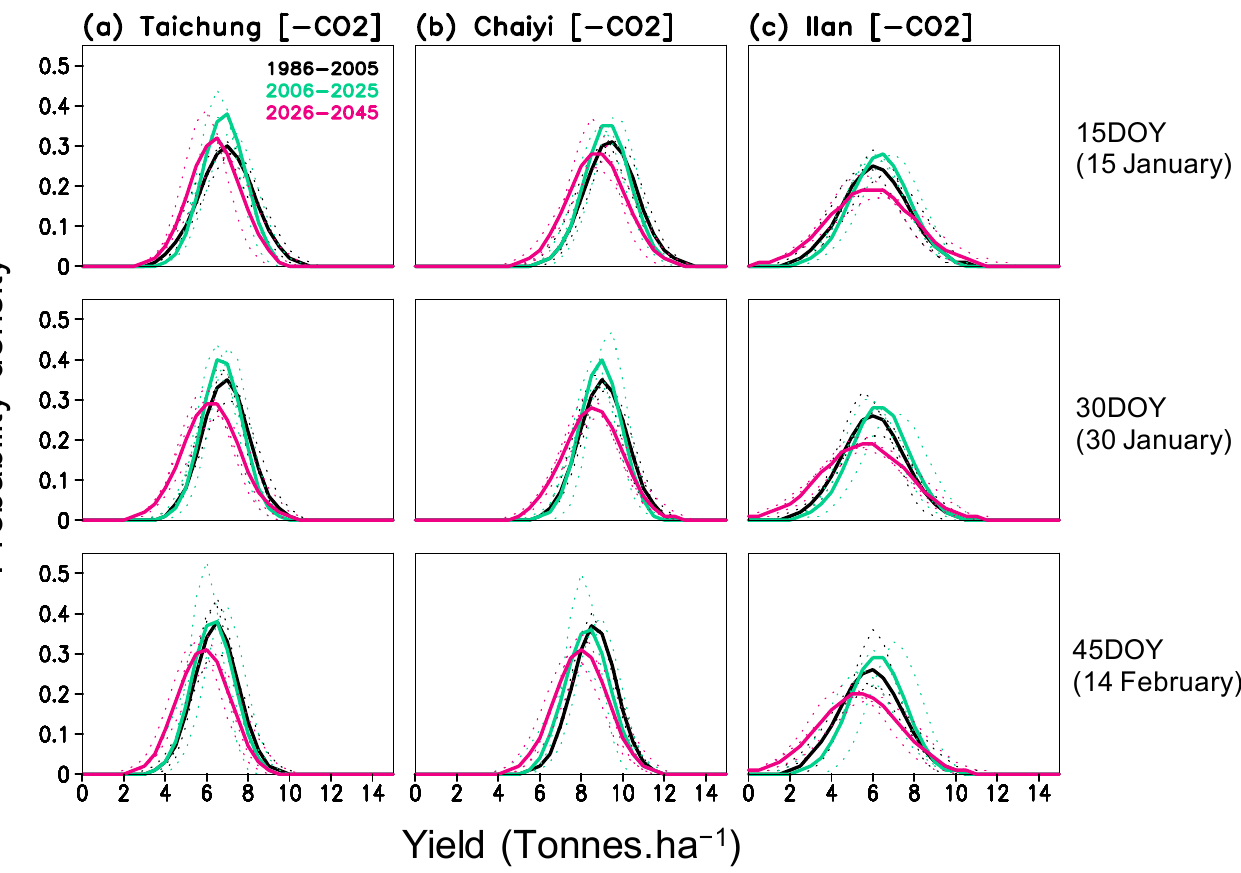
Figure 9. Probability density function of simulated yield (without projected CO 2 ) for three planting dates (15, 30, 45 day of year) and three periods (1986–2005, 2006–2025, 2026–2045) constructed for ( a ) Taichung, ( b ) Chaiyi, and ( c ) Ilan; solid lines are averaged values from 3 models and dotted lines are values of each model.